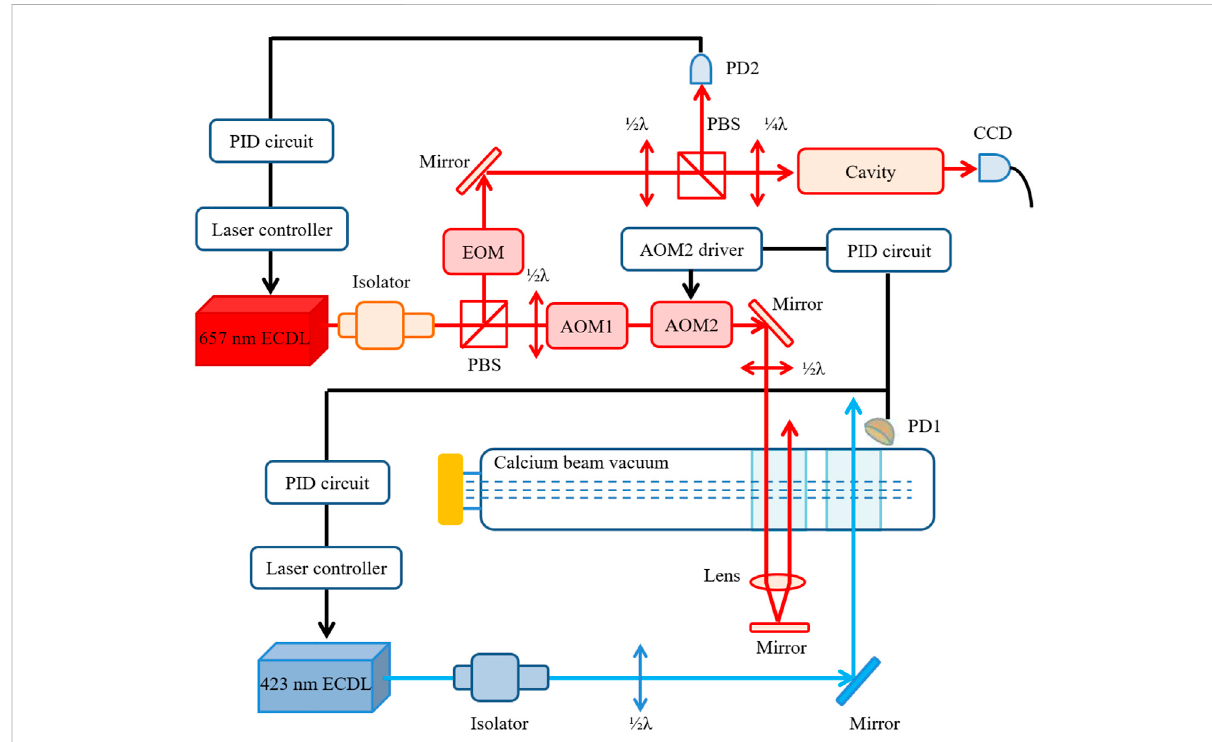
FIGURE 2 Schemeofthecalciumbeamfrequencystandard.The423 nmECDLislockedto 1 S 0 - 1 P 1 transitionandusedasareadoutlaser.The657 nmlaser is fi rst locked to a cavity. Then the laser frequency is shifted and locked to 1 S 0 - 3 P 1 transition through two AOMs.